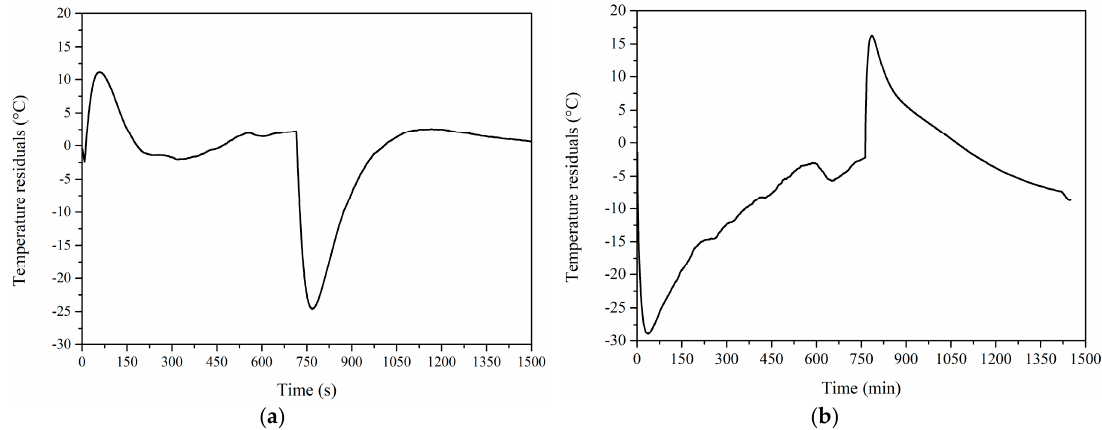
Figure 9. Temperature residuals for ( a ) linear case and ( b ) dynamic case.